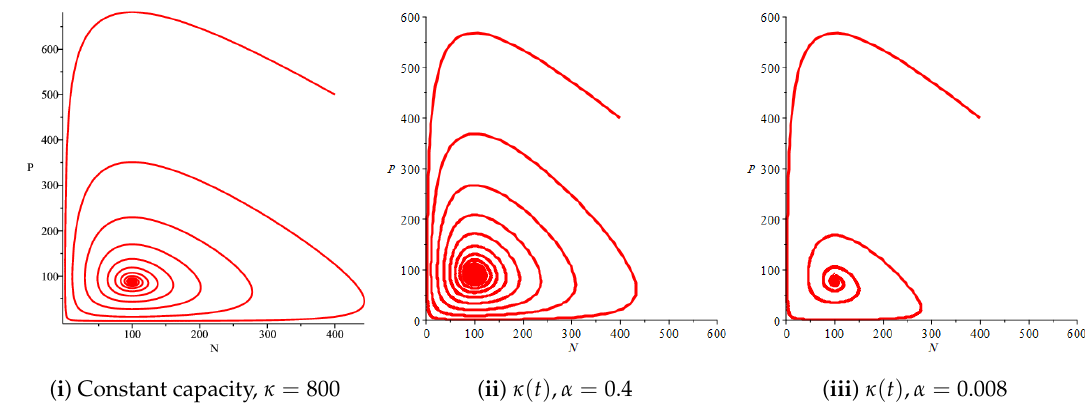
Figure 3. Effect of the logistic variable varying capacity on the phase space of the prey and predator model with linear response for κ 1 = 300, κ 2 = 500, r = c = 0.25, a = b =